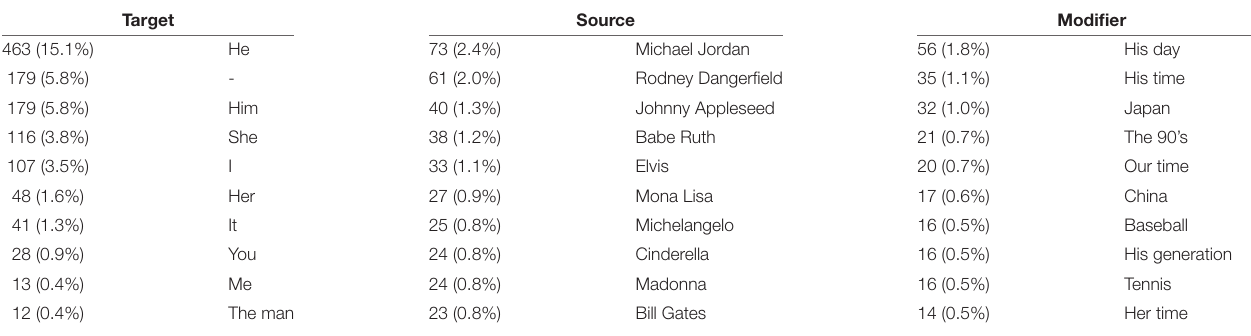
TABLE 1 | The most frequent appearances for each VA chunk together with their